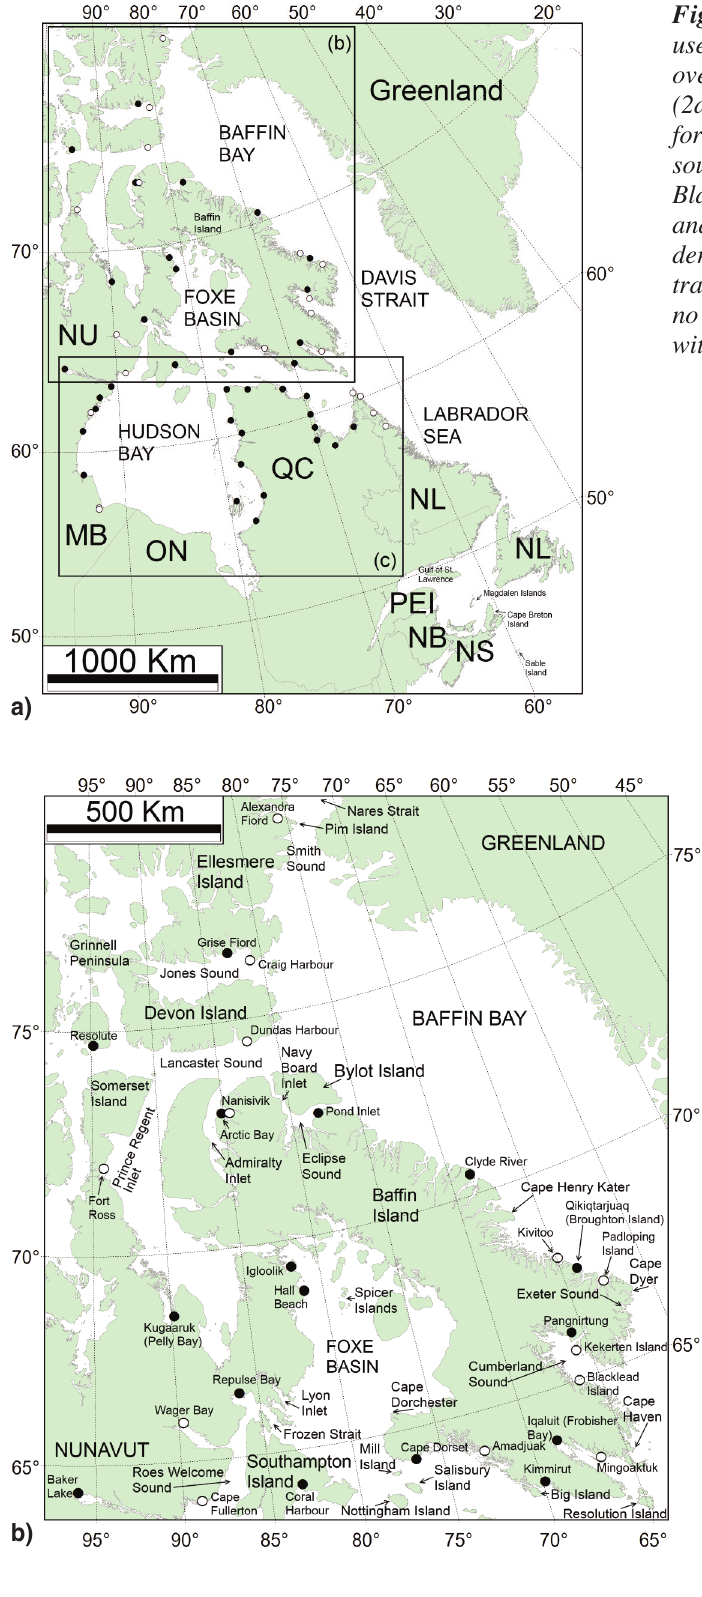
Fig. 2a–c. Key place names used in text shown on an overview of eastern Canada (2a) with inset maps expanded for the regions north (2b) and south (2c) of Hudson Strait. Black dots denote communities and white dots with black bor- ders denote whaling stations or trading posts. Historical